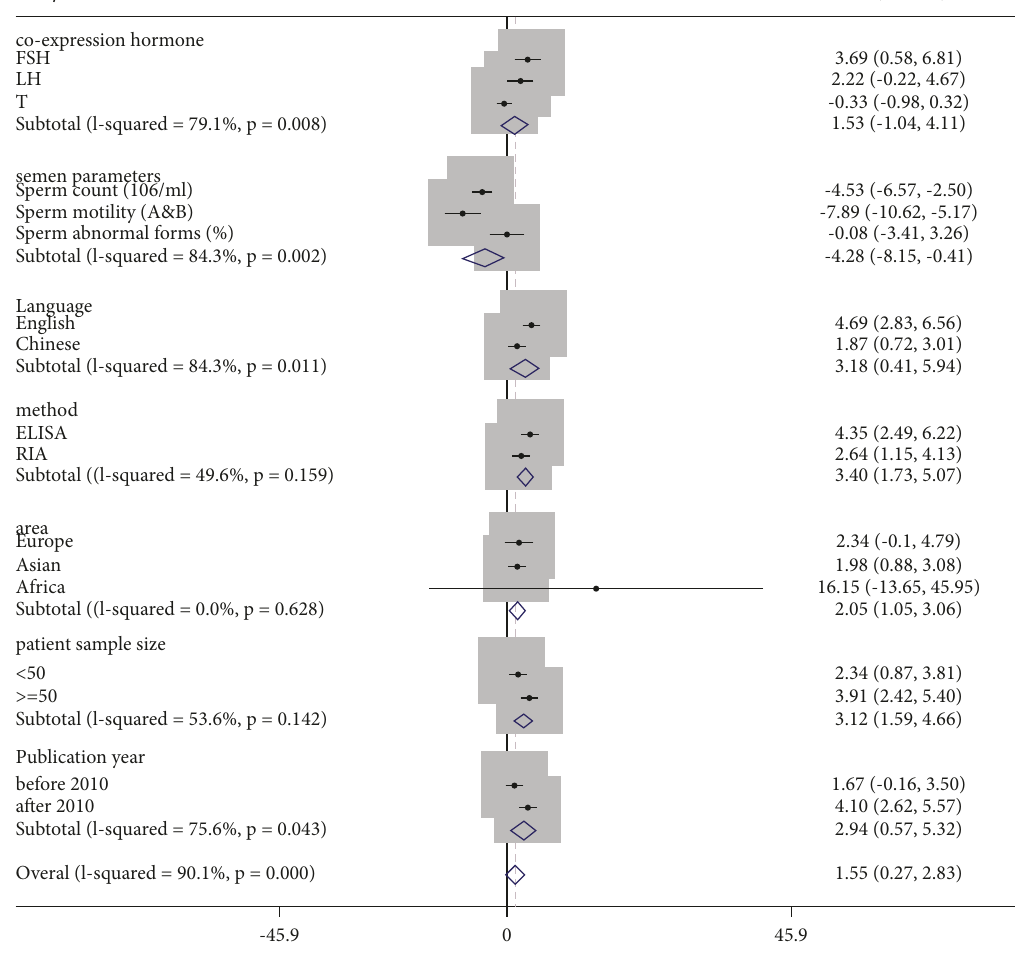
Figure 5: The estimates of SMD are based on 12 eligible studies providing seminal leptin concentration with their 95% CIs. Note: FSH: follicle-stimulating hormone; LH: luteinizing hormone; T: testosterone; ELISA: enzyme-linked immunosorbent assay; RIA: